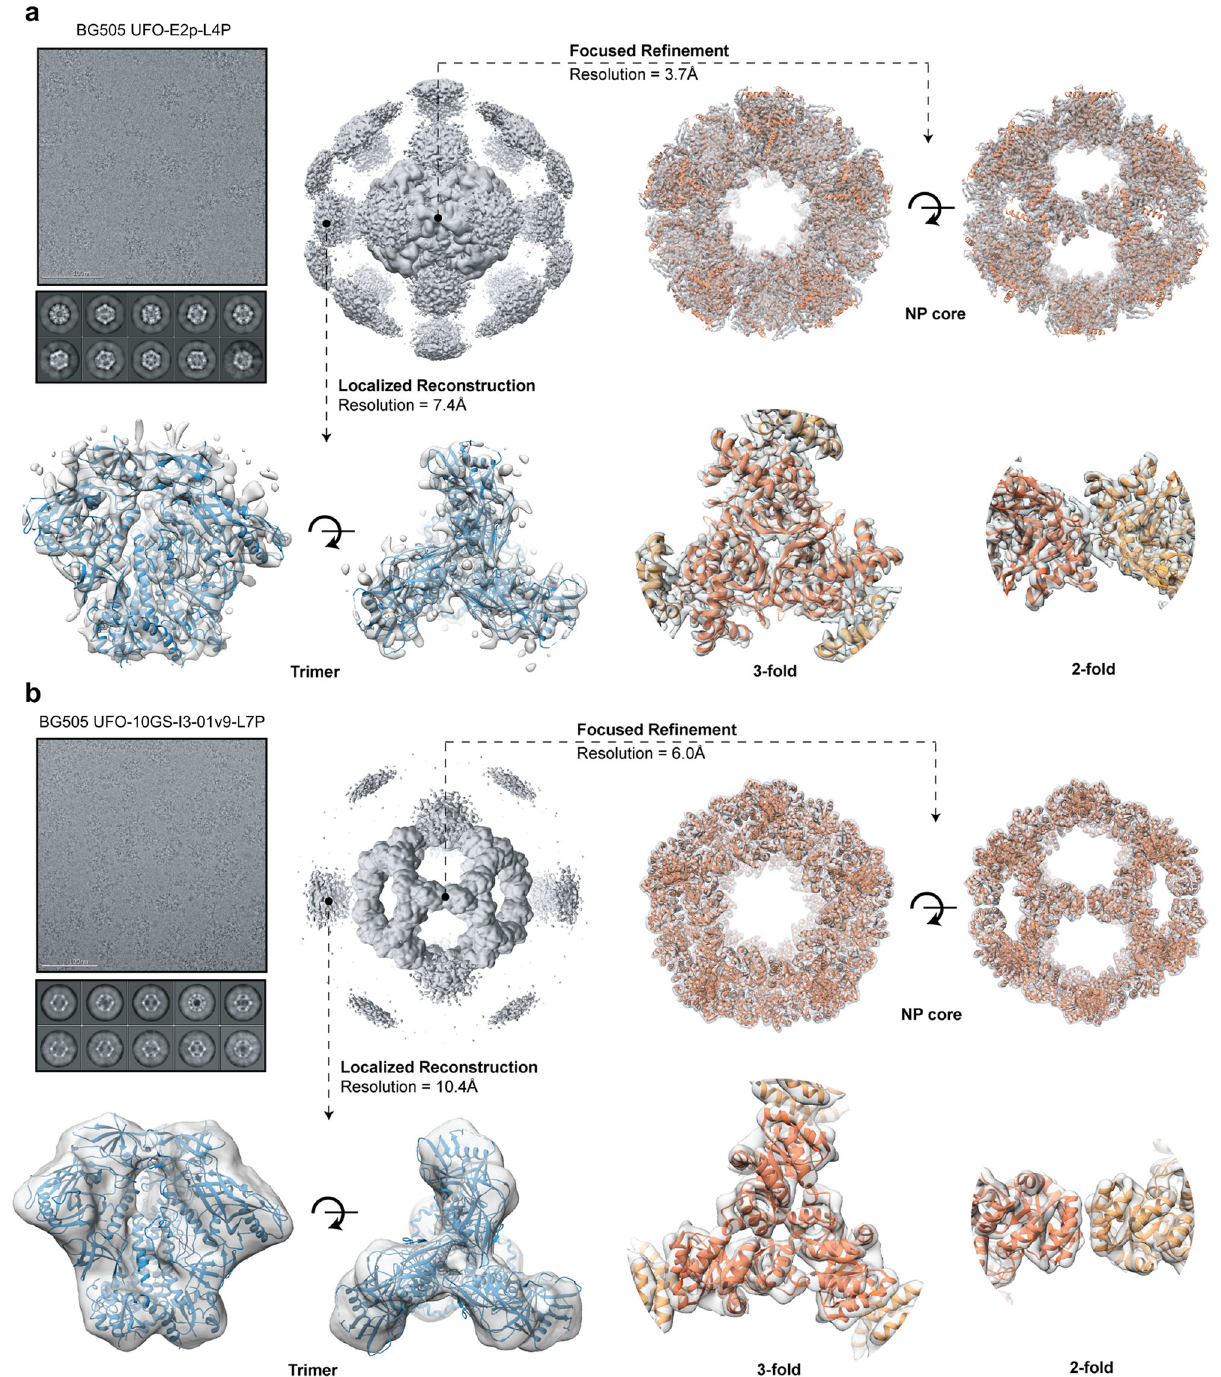
Fig. 2 | Cryo-EM analysis of the multilayered BG505 UFO trimer-presenting nanoparticles. Two PGT145/SEC-puri fi ed SApNPs were analyzed. a BG505 UFO- E2p-L4P. b UFO-10GS-I3-01v9-L7P. Representative raw cryo-EM micrographs, 2D classes and 3D maps featuring full SApNPs (with trimer antigens) are displayed in thetopleftpartofthecorrespondingpanels.Focusedclassi fi cationandre fi nement were applied to reconstruct a 3D map of the SApNP core (top and bottom right),